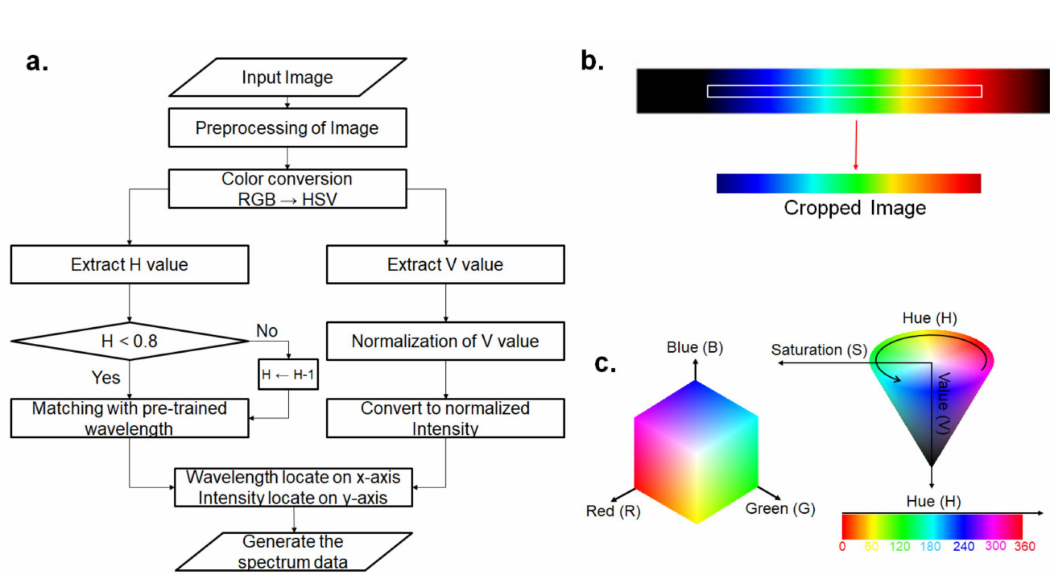
Figure 6. Image processing algorithm: ( a ) flow chart and ( b ) cropped image, ( c ) RGB vs. the hue ( H ), saturation ( S ), and value ( V ) color